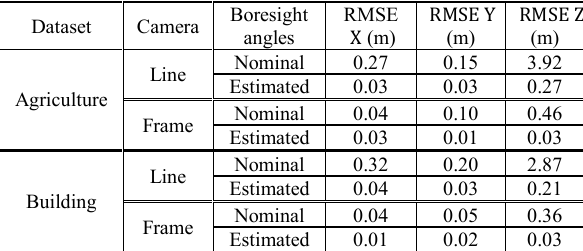
Table 3. Absolute accuracy of the multi-modal triangulation procedure for the two datasets used in this